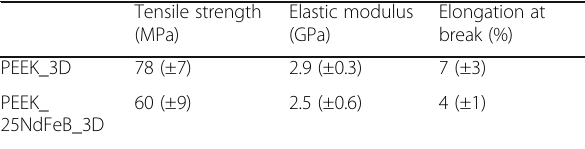
Table 12 Values of tensile strength, elastic modulus and elongation at break for neat PEEK and PEEK_25NdFeB 3D printed parts